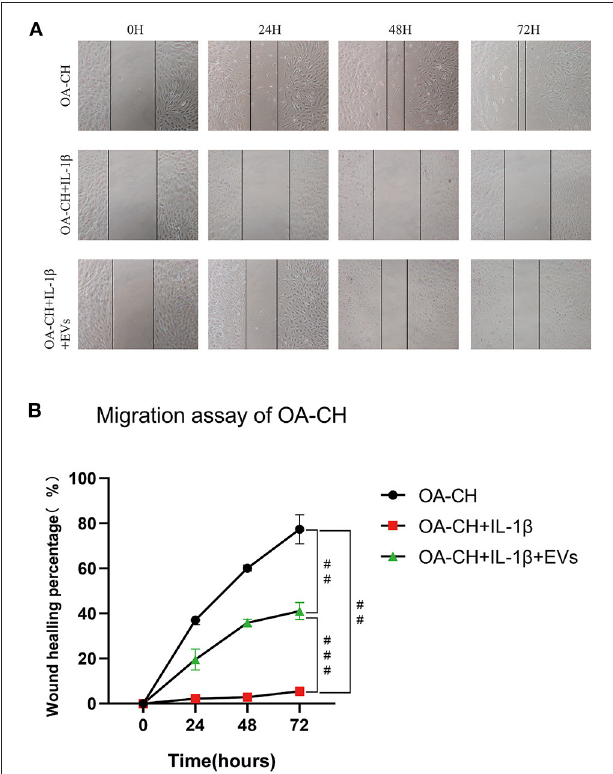
FIGURE 4 | Effect of hBMSC-EVs on migration of OA-CH and IL-1 β -induced OA-CH. (A) A scratch (wound healing) assay was used to evaluate the effect of hBMSC-EVs on migration of IL-1 β -induced OA-CH. Pictures of gaps were taken 0, 24, 48, and 72h after treatment of cells with EVs and IL-1 β . (B) Gap closure percentage was used to calculate the migration ability of each group. The OA-CH group without treatment is used as migration control (black bars); # p < 0.05; ## p < 0.01; ### p < 0.001. One-way ANOVA with Newman– Keuls Multiple Comparison Test; n =